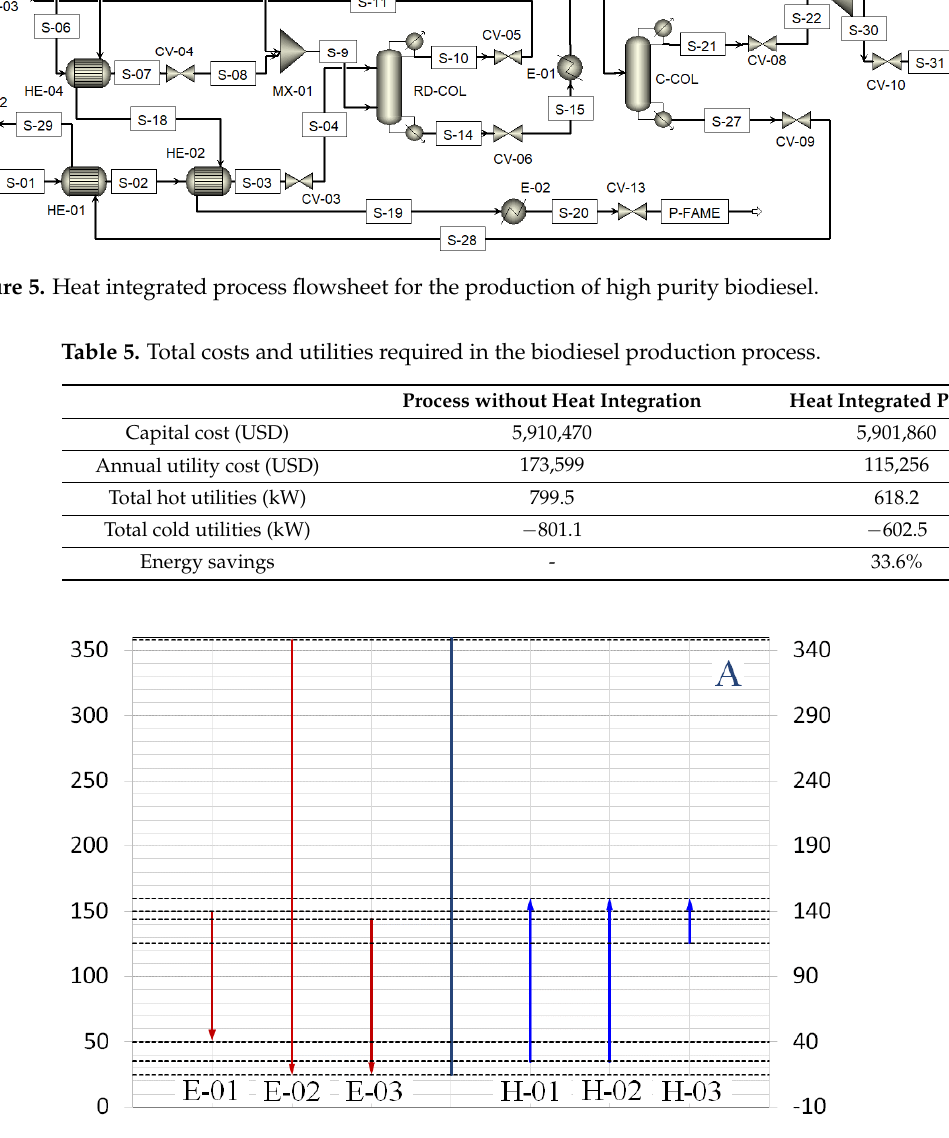
Figure 6. Temperature interval